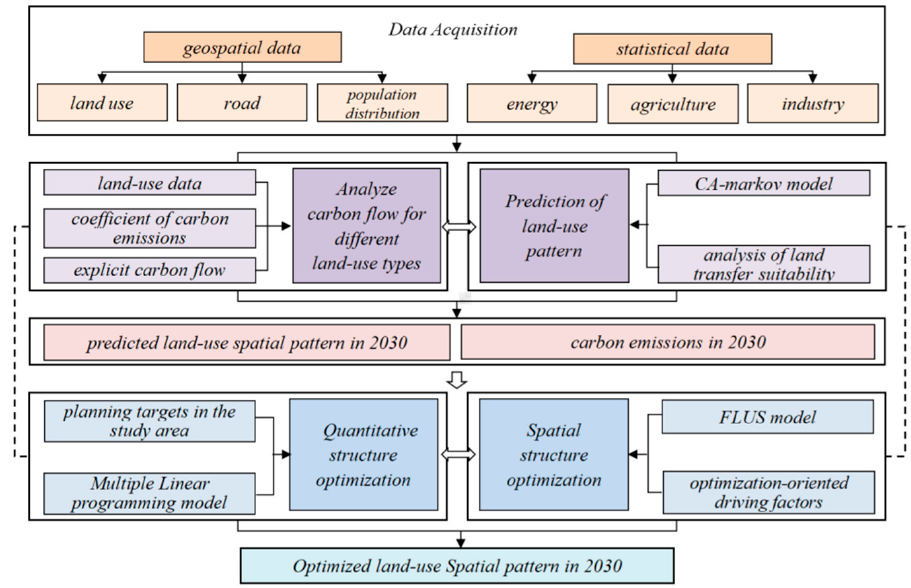
Figure 2. The technology roadmap of this study.